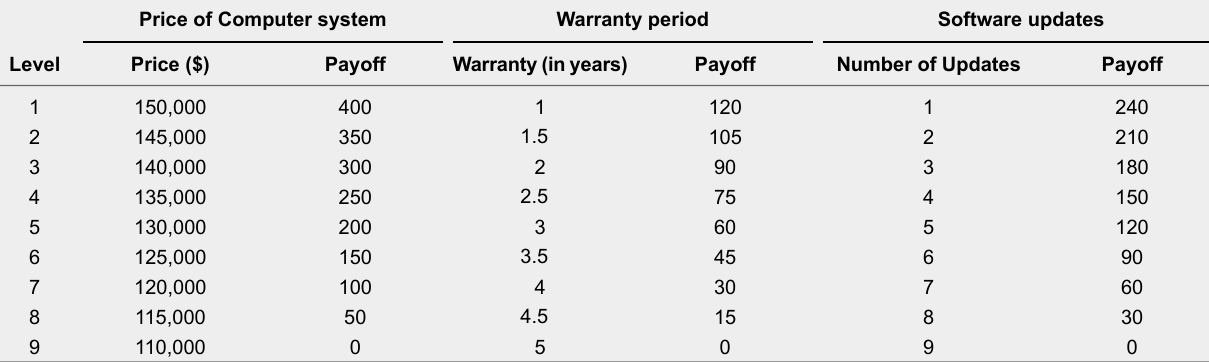
Software updatesWarranty periodPrice of Computer system